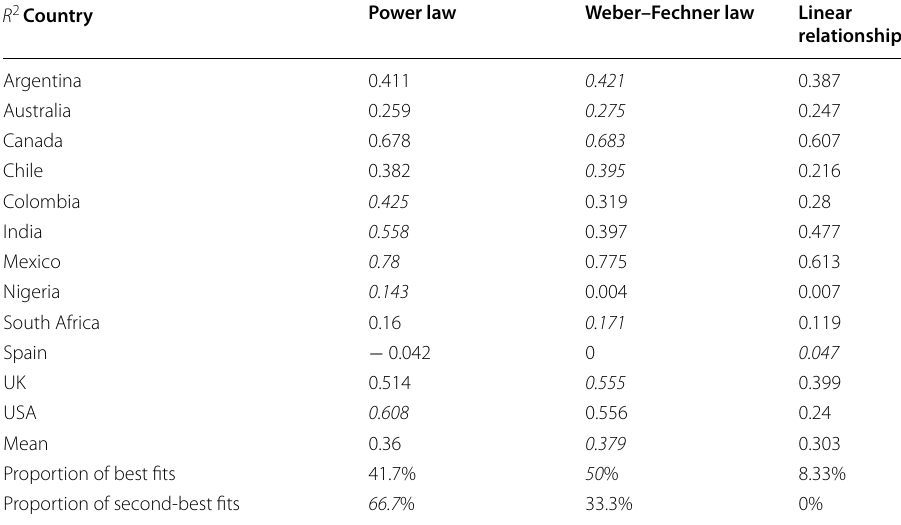
Table 7 Comparison of R 2 between the models of attention